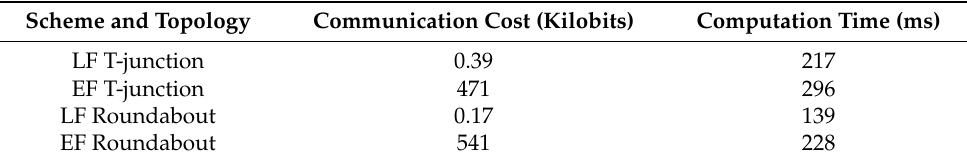
Table 2. Comparative performance analysis between late and early fusion schemes. Scheme and